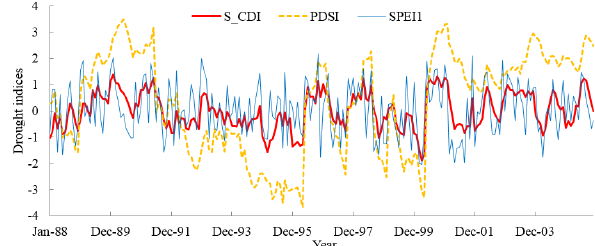
Figure 2. Temporal variations of the short-term CDI and its com- ponents.